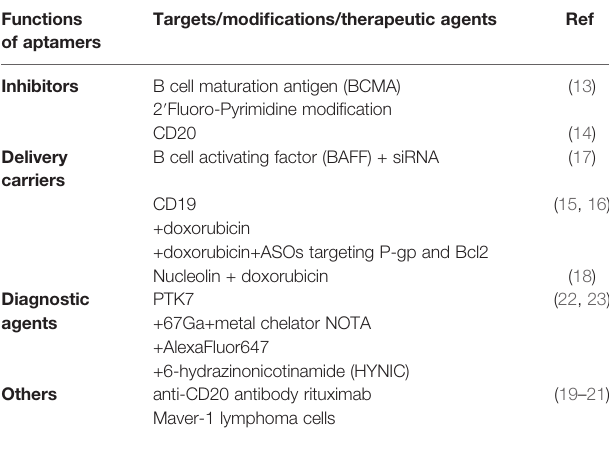
TABLE 3 | Aptamers-based research on immune